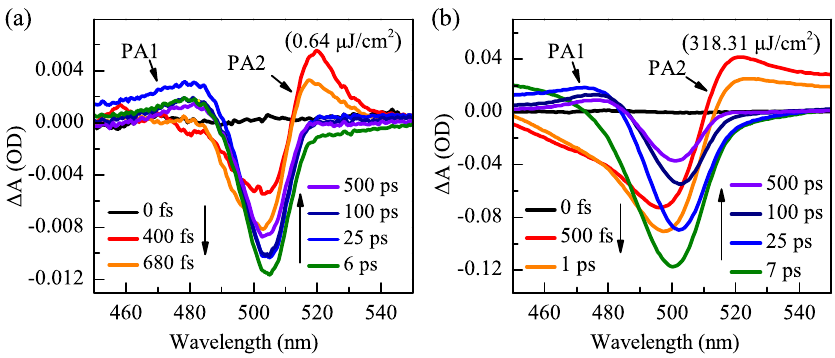
Figure 3. ( a ) TA spectra of CsPbBr 3 NCs at the indicated delay time under the lowest pump fluence at 365 nm. ( b ) TA spectra of CsPbBr 3 NCs at higher pump fluence at 365